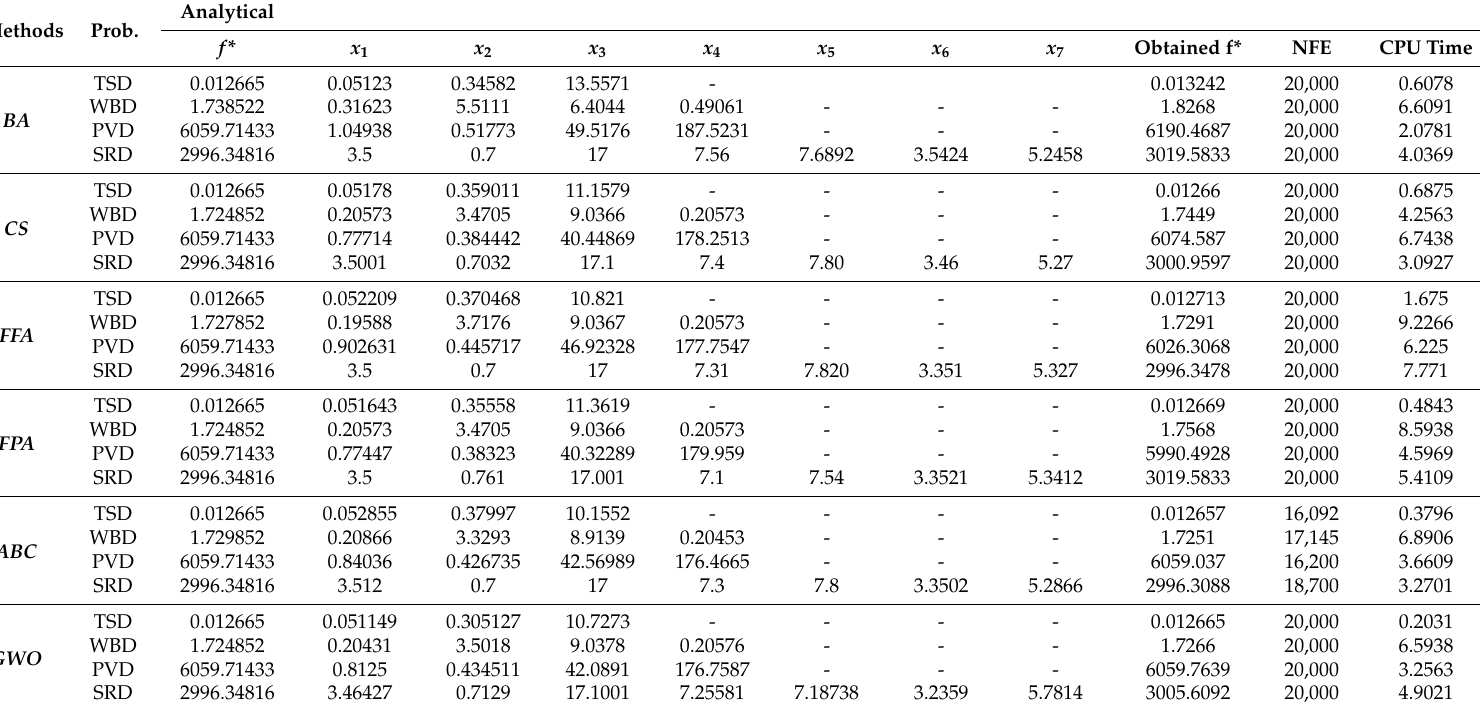
Table 5. This table is a summary of results for nonlinear constrained engineering